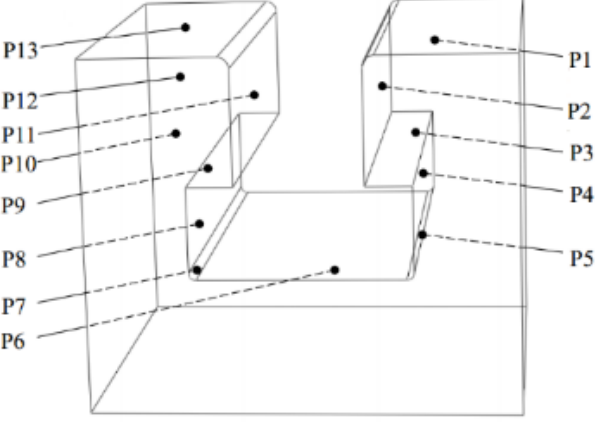
Figure 3. T-Groove( P1-P13 are the correlation surfaces of the features).